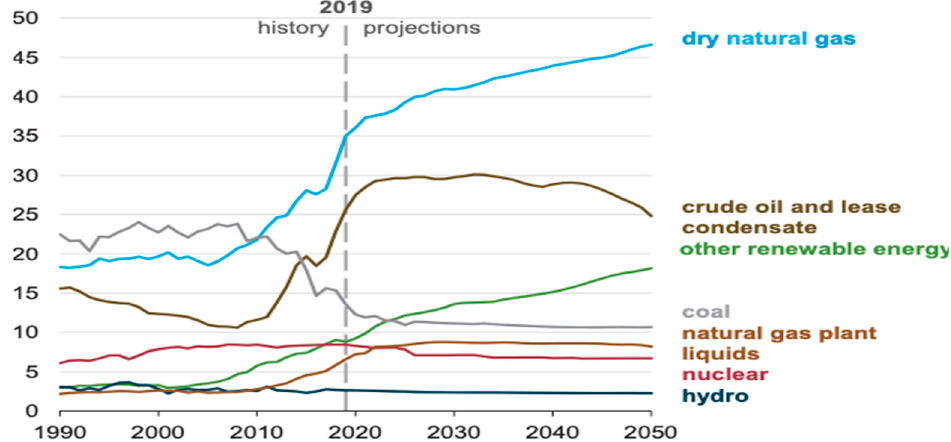
Figure 1. Energy production in quadrillion British thermal units (AEO2020).